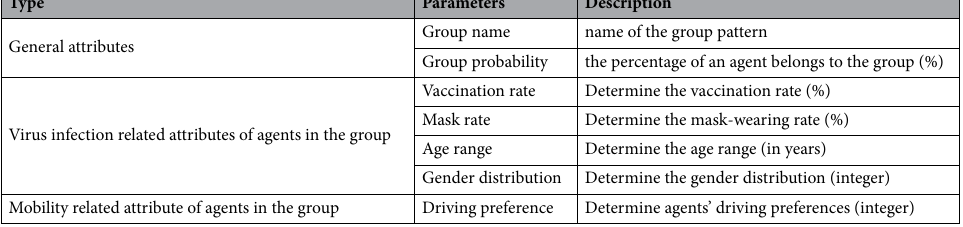
Table 1. Parameters of the group pattern.